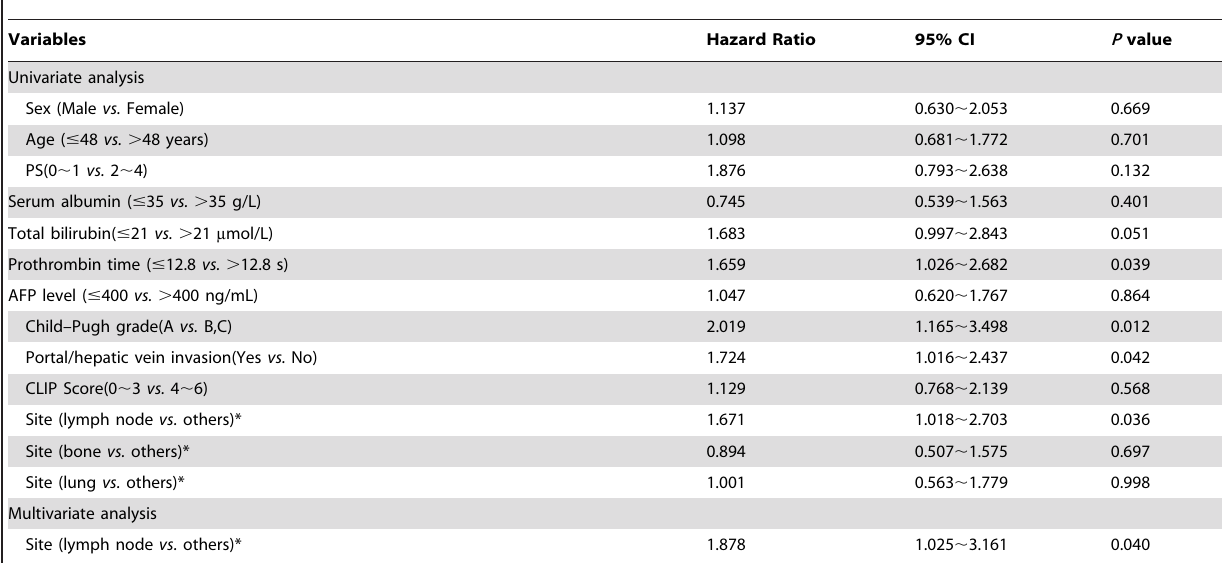
Table 3. Univariate and multivariate analyses of predictors of survival for the HCC patients with extrahepatic metastasis.